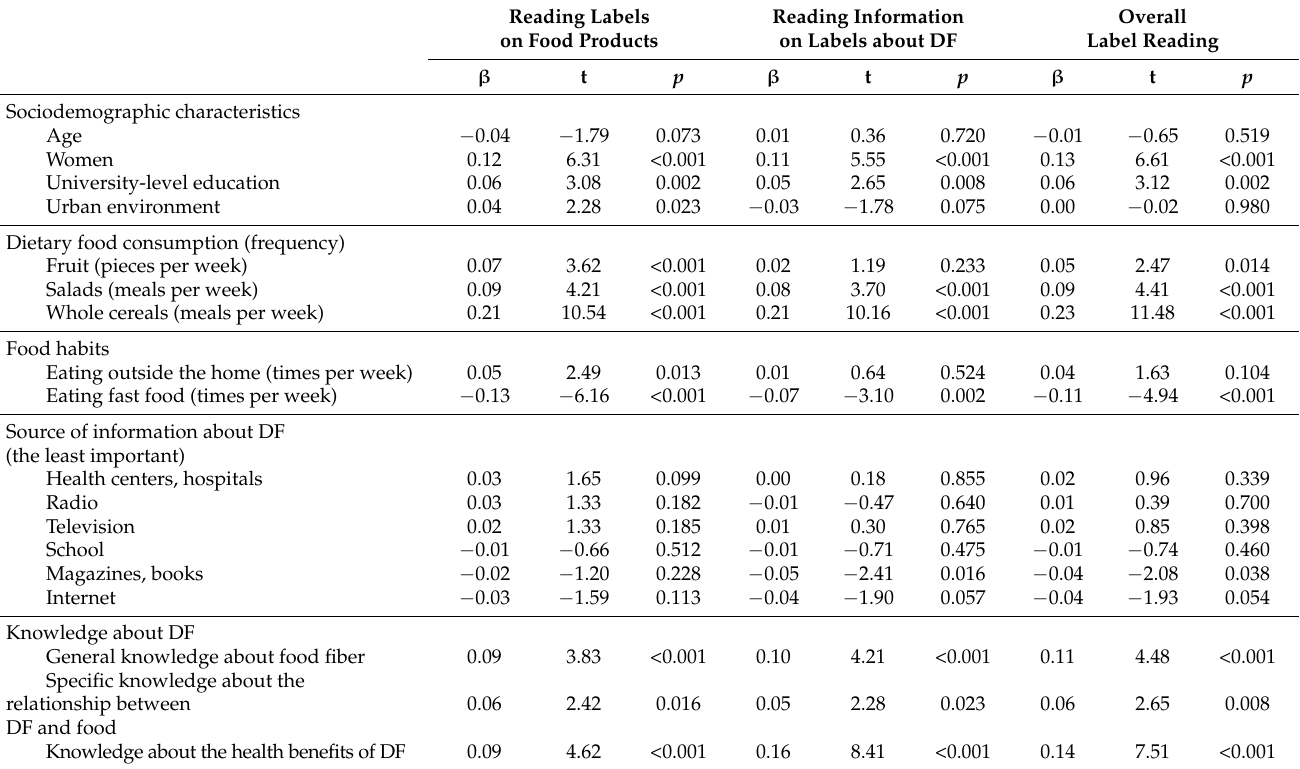
Table 3. Associations between lifestyle habits, knowledge about dietary fiber, and reading food labels in the study group determined using linear regression